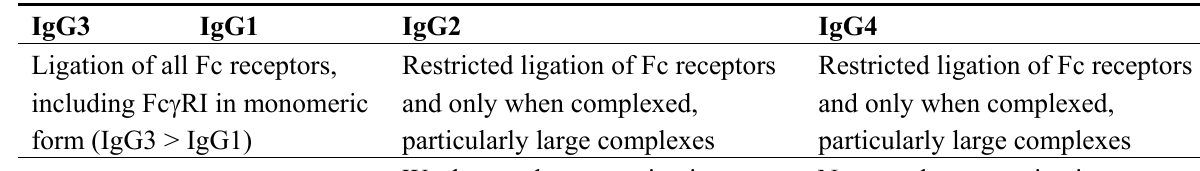
Table 1. Isotype diversification of IgG antibodies leads to broadening of the function of an IgG antibody response.